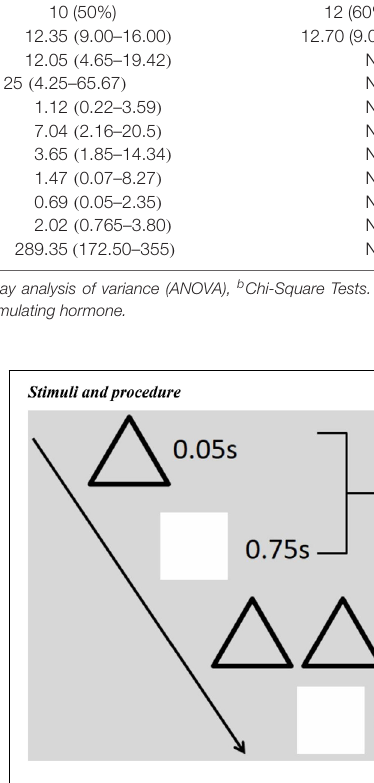
FIGURE 1 | Illustration of the stimulus paradigm applied. There are three blocks in total, and each block includes 60 Go and 40 Nogo stimuli. Each stimulus emerged for 50 ms, followed by an inter-stimulus interval (750 ms). As soon as the Go (double triangles) stimuli appeared onto the screen, the subjects should press the button quickly but should not press the button when the Nogo (single triangles) stimuli turned